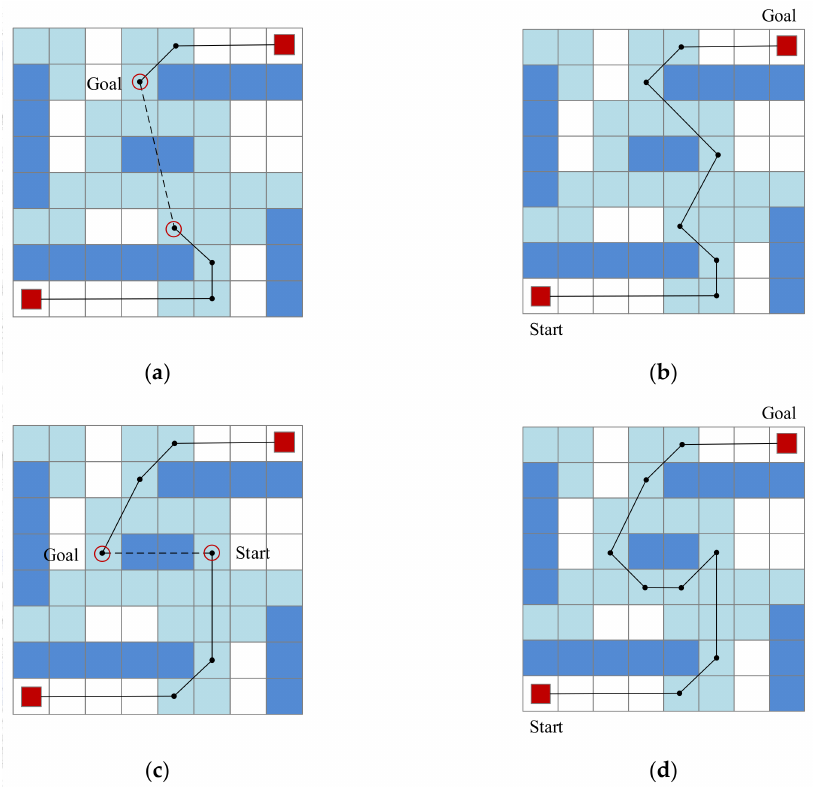
Figure 18. Children of crossover operation. ( a ) Original Child 1; ( b ) modified Child 1; ( c ) original Child 2; ( d ) modified Child